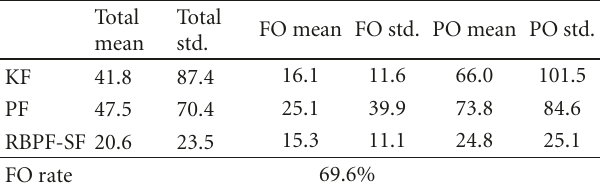
Table 3: Comparisons of average tracking errors in cm among KF, PF, and RBPF-SF. (FO: Fully observable. PO: Partially observable.) Total